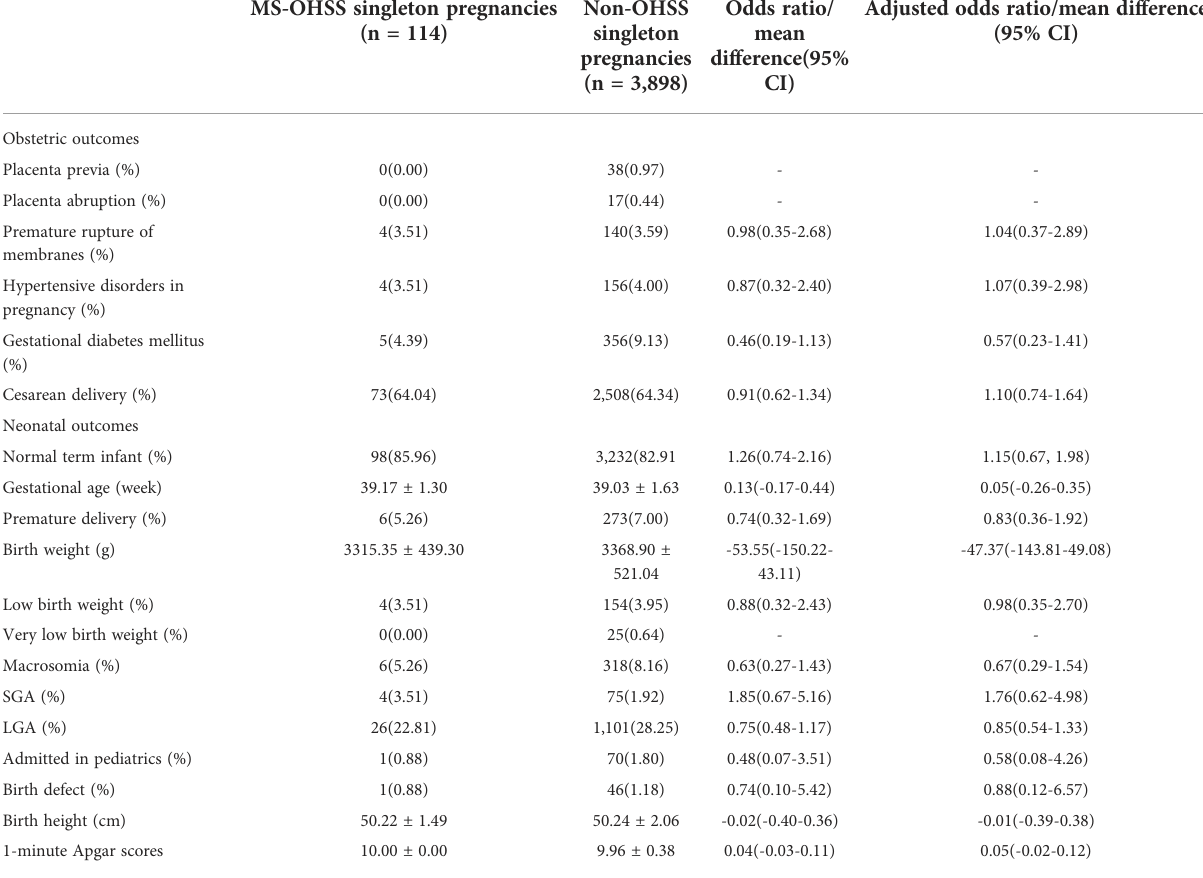
TABLE 2 Perinatal outcomes among MS-OHSS patients and Non-OHSS patients before propensity score